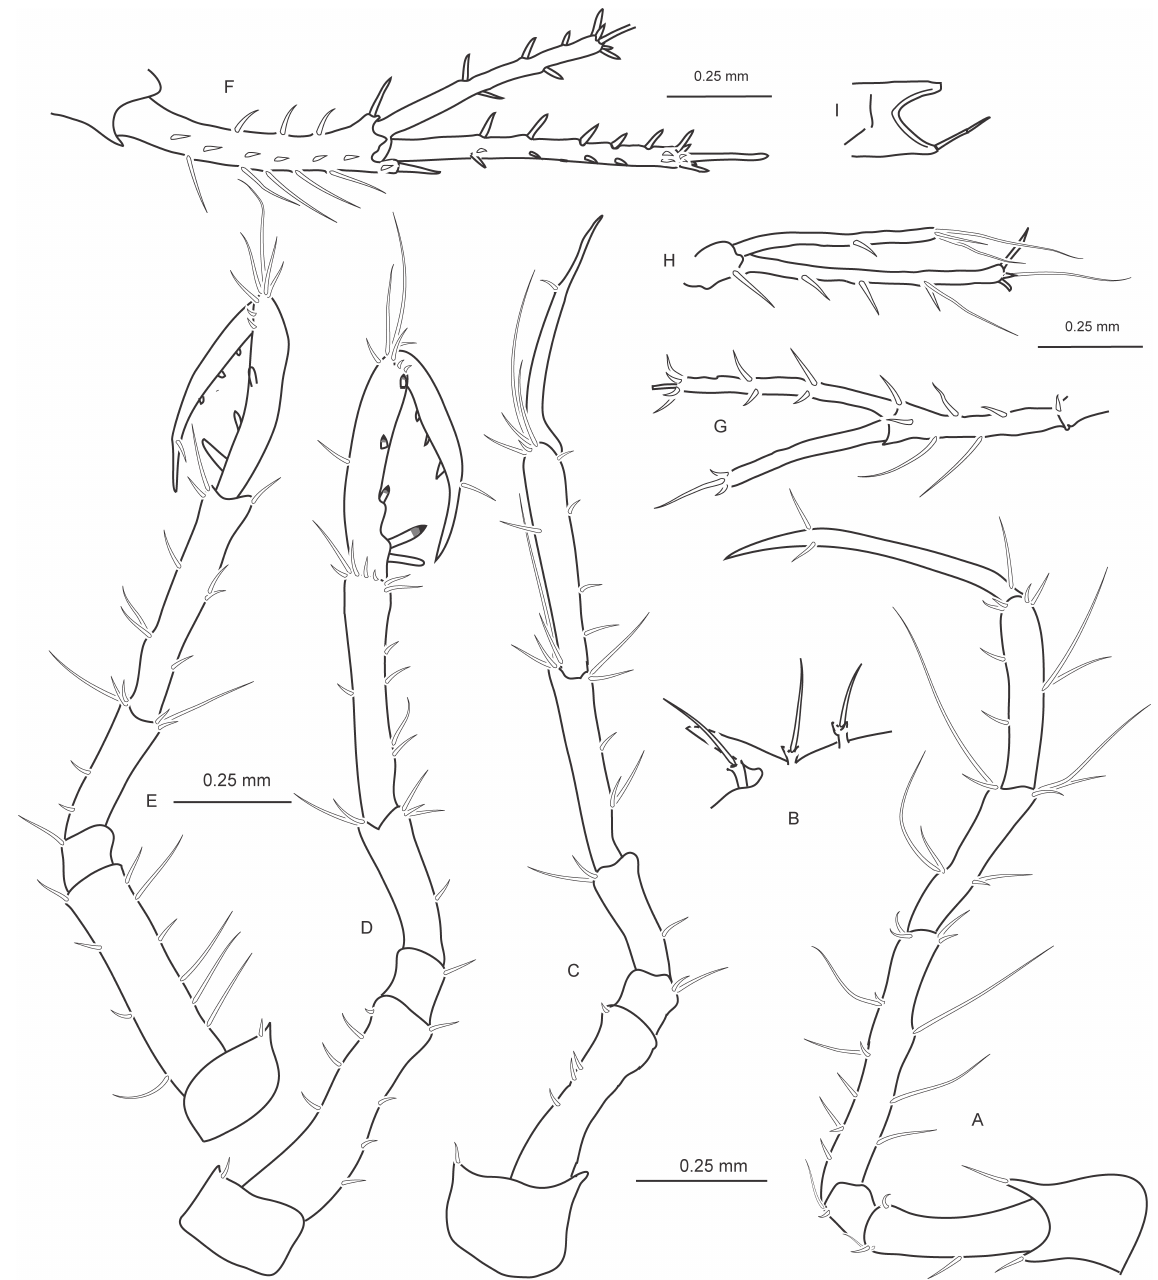
Fig. 19. Lepesubchela christinae gen. et sp. nov., holotype, immature. A . Left P4. B . Tooth of peraeon segment 5. C . Left P5. D . Left P6. E . Right P7. F . Left U1. G . Right U2. H . U3. I